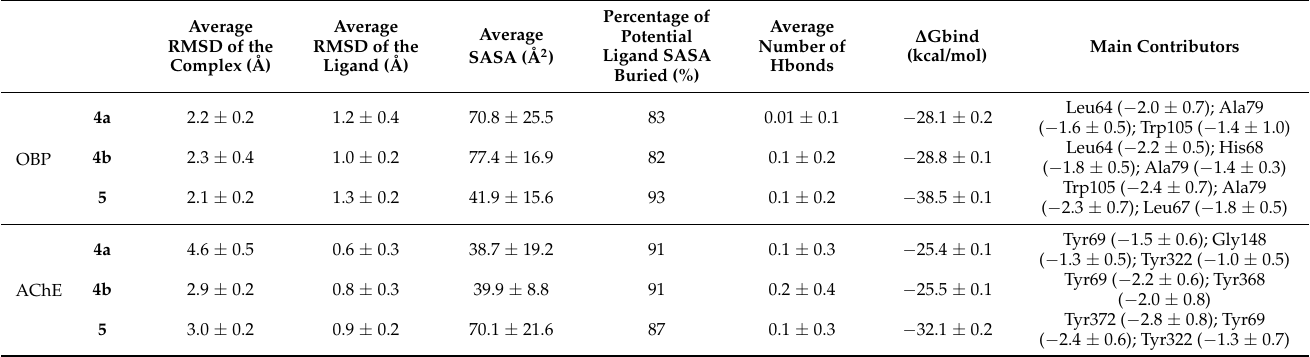
Table 3. Average RMSD values (Å), ligand RMSF (Å), average SASA (Å 2 ), percentage of potential ligand SASA buried and the average number of hydrogen bonds for the ligands for the last 70 ns of the simulation of the OBP and AChE–ligand